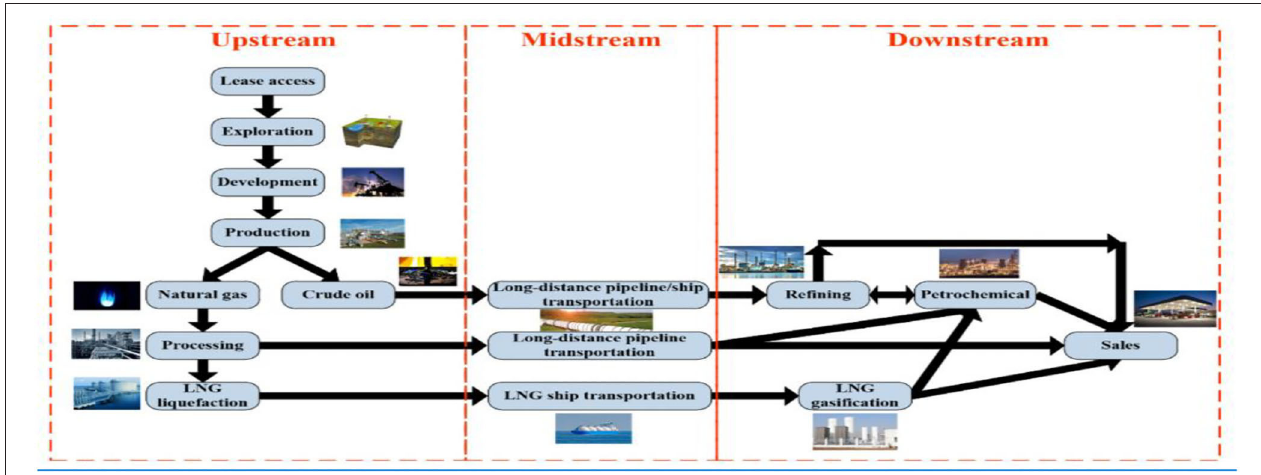
FIGURE 1 | Upstream, midstream, and downstream operations in the oil and gas sector. Source